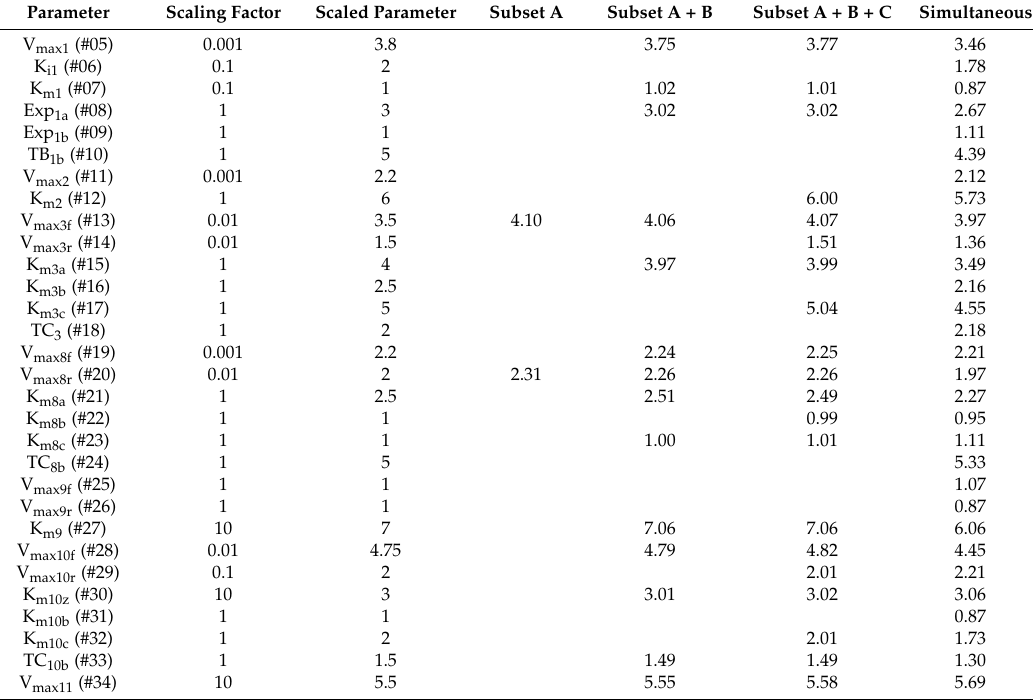
Table 1. Parameter values of CHO Cell model obtained via simultaneous and sequential parameter